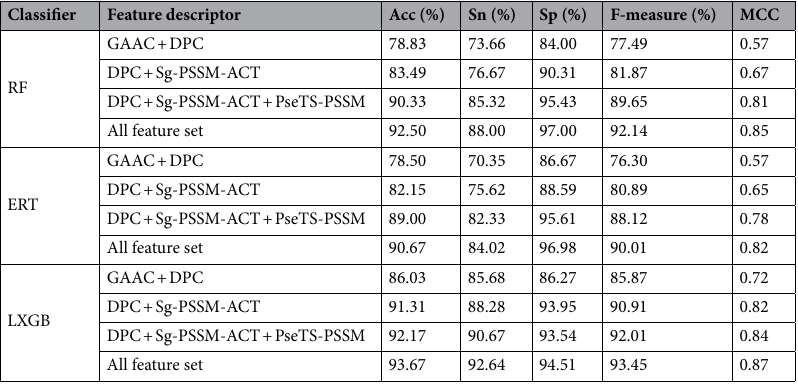
Table 3. Results based on hybrid